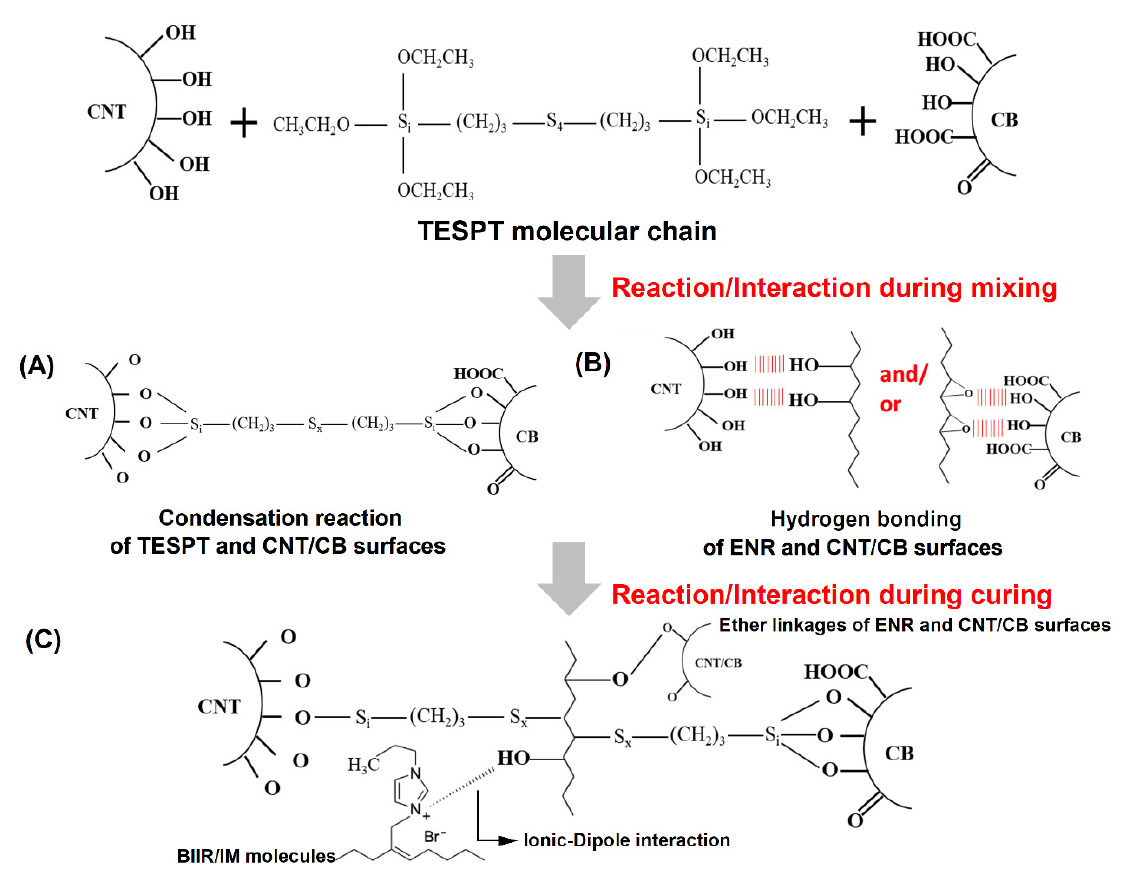
Figure 3. Proposed reaction propagation that occurred during mixing operation of CNT/CCB and TESPT ( A ) and ENR molecular chains ( B ) and during the compression molding by crosslinking with ENR molecules and by both ENR molecules and ion–dipole intermolecular chain ( C ).